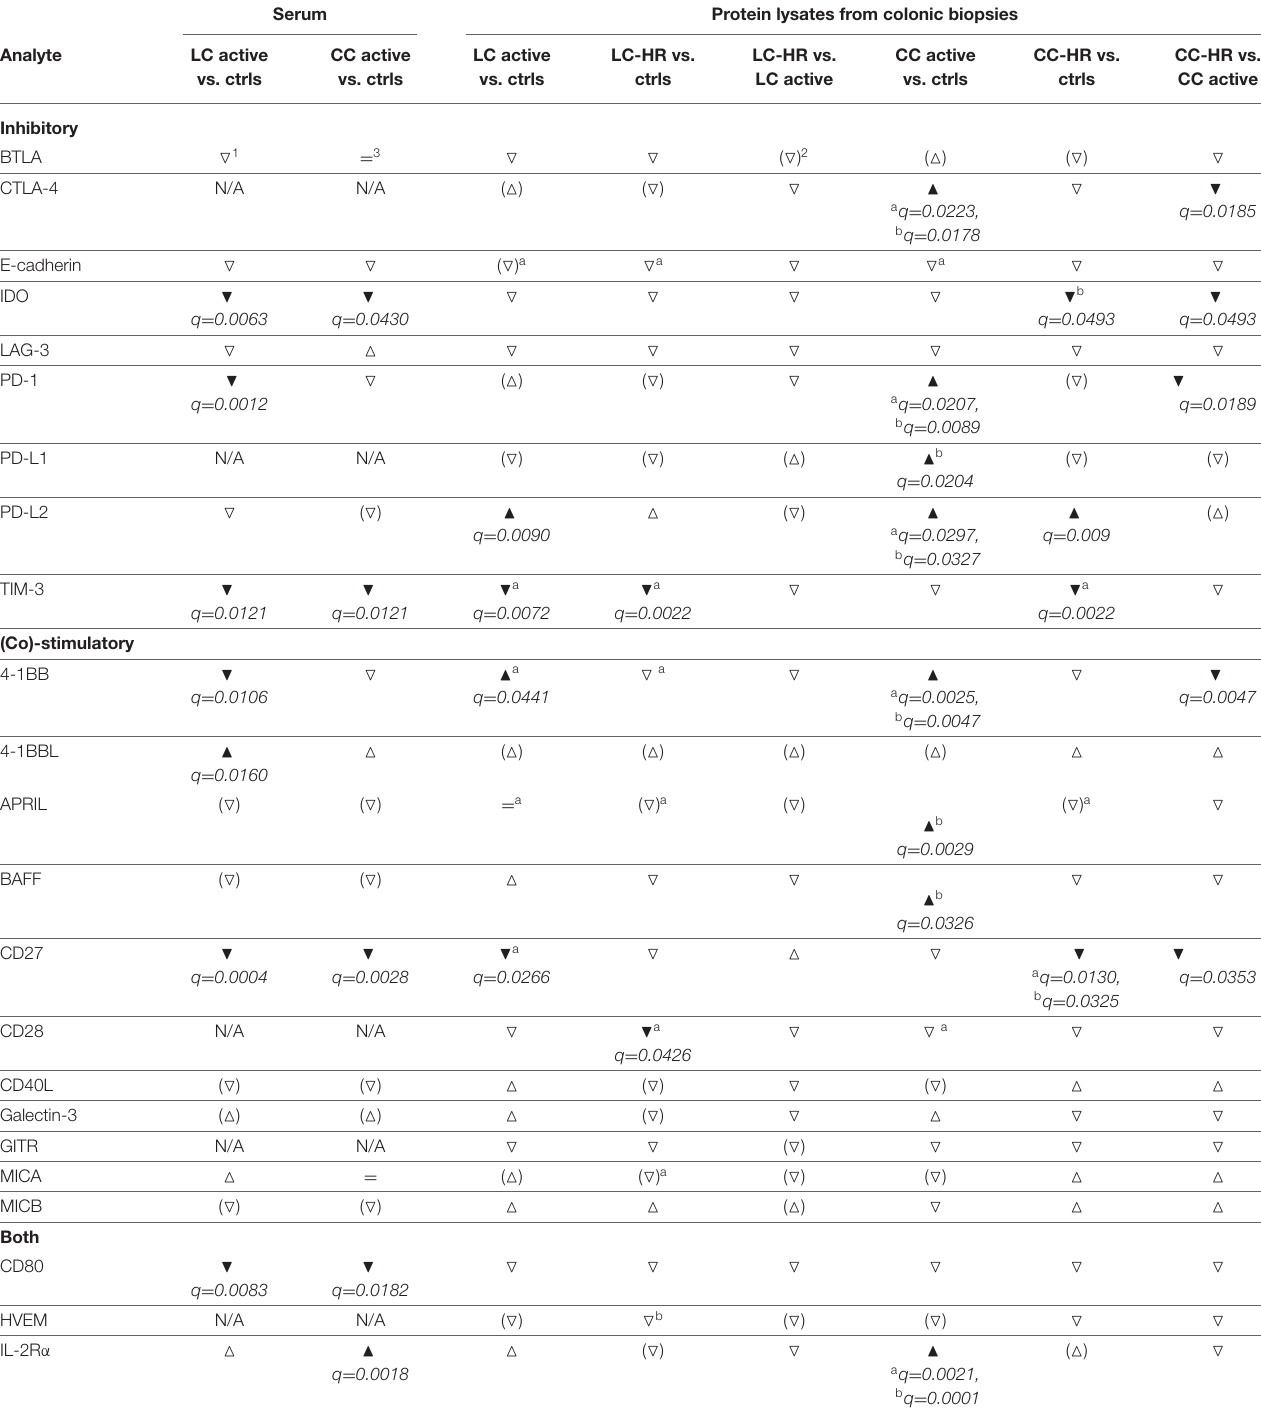
TABLE 5 | Summary of changes in all analytes in serum and in biopsies from patients with lymphocytic colitis (LC) or collagenous colitis (CC) with active disease and in histological remission (HR). Analyte LC active